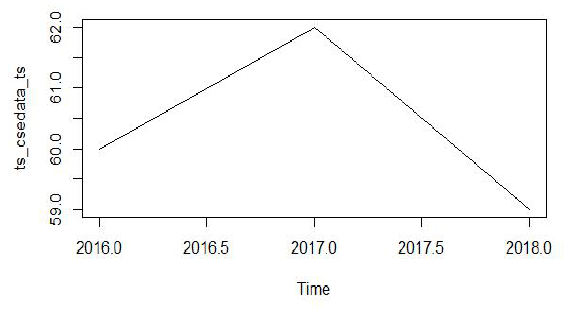
Figure 4. Time series plot of data set ARIMA